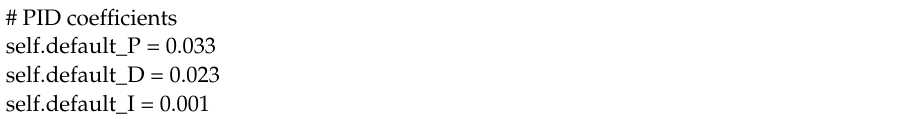
Algorithm 8. Fragment of the Python code: PID controller coefficients default values.